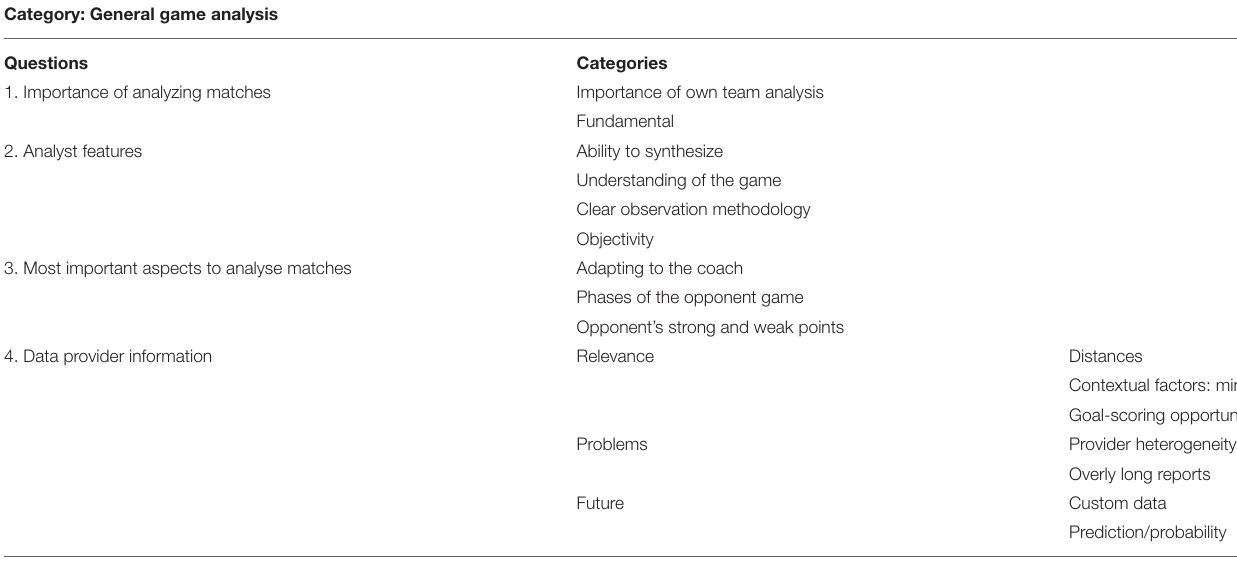
TABLE 1 | Questions and categories in the general section of the